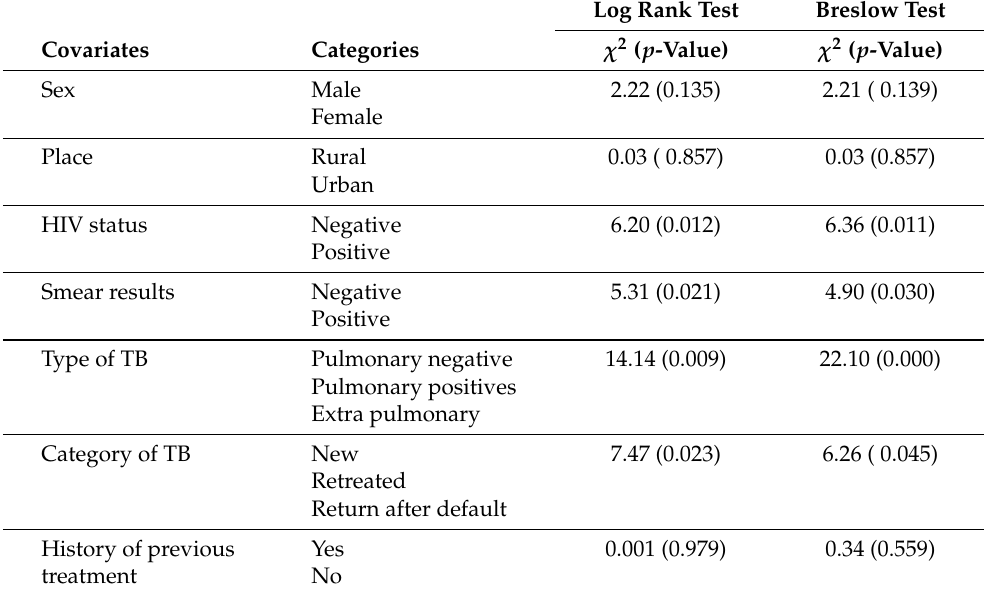
Table 3. Chi-square estimate ( χ 2 ) and p -value of log-rank and Breslow tests for comparing the survival experience of TB patients from randomly selected governmental hospitals in southwest Ethiopia. Log Rank